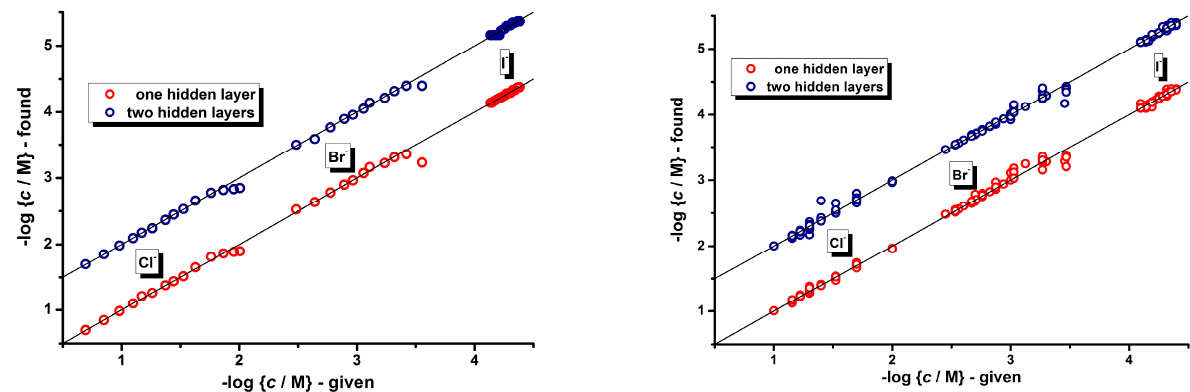
Figure 6. The results of analysis of single halides (left panel) or mixture of halides (right panel) by ANN analysis. The blue points were shifted by value +1 for the sake of clarity. The ANN architecture for single analysis with one hidden layer: 51:5:1 (chloride, bromide), 51:7:1 (iodide), two hidden layers: 51:4,5:1 (chloride), 51:5,6:1 (bromide), 51:6,7:1 (iodide). The ANN architecture for ana-lysis of mixture with one hidden layer: 51:7:2 (chloride–iodide), 51:6:2 (bromide–iodide, bromide–chloride), two hidden layers: 51:6,7:2 (chloride–iodide), 51:5,6:2 (bromide–iodide, bromide–chloride).